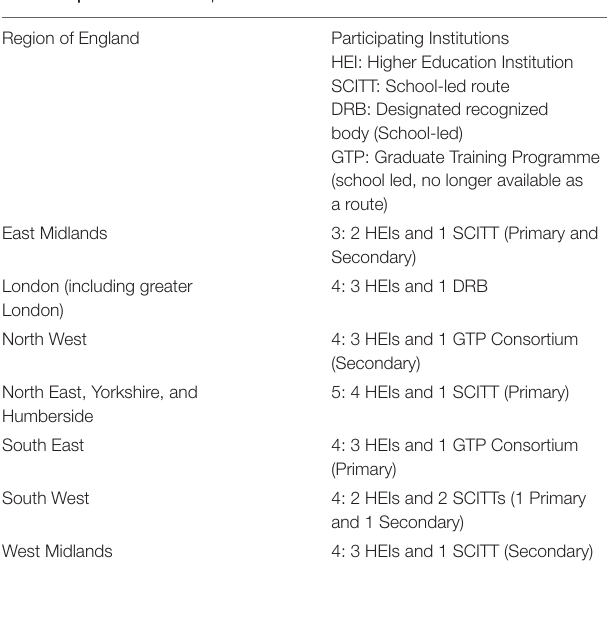
TABLE 1 | Overview of sample. Region of